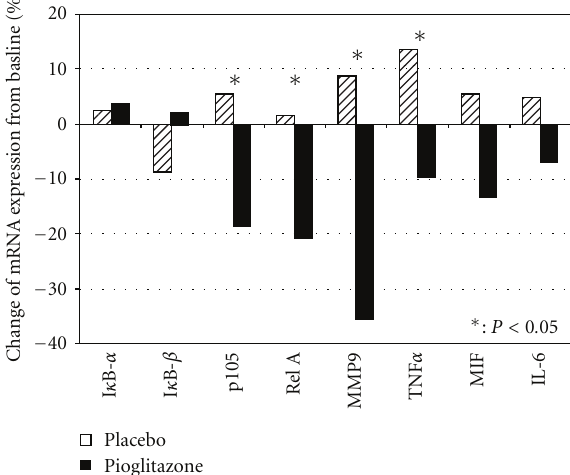
Figure 2: Percent changes in proinflammatory mRNA expression markers from baseline to week